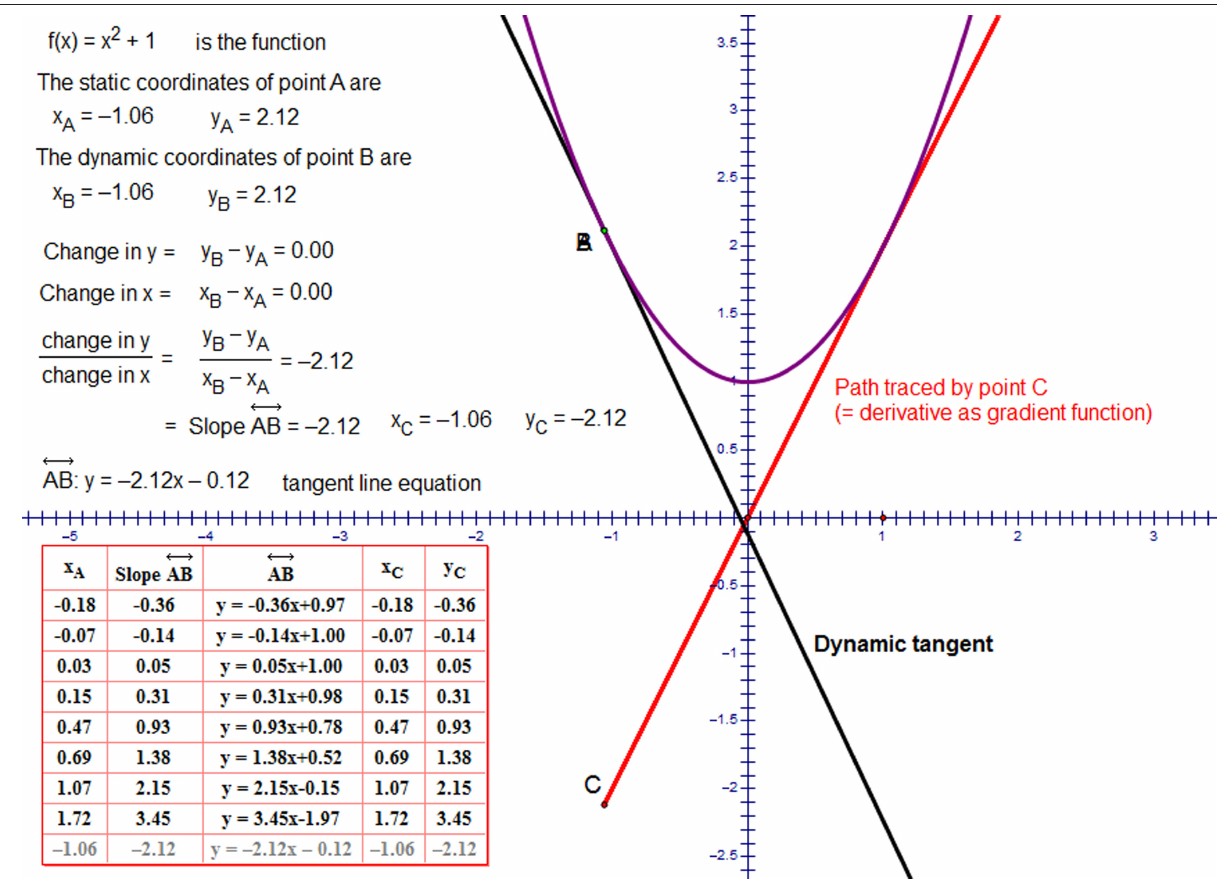
FIGURE 4: Modelling the rate of change (slope) function in Sketchpad.